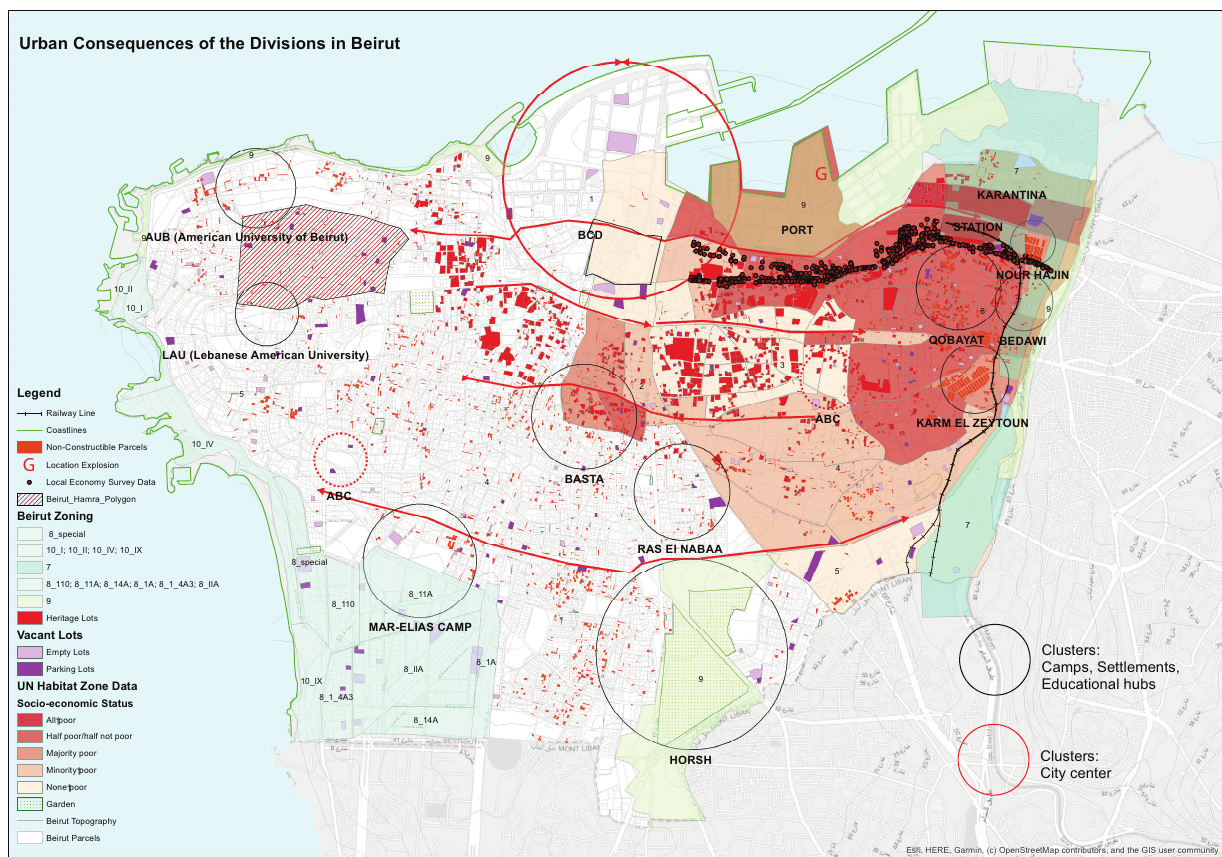
Figure 2. Urban consequences of the divisions in